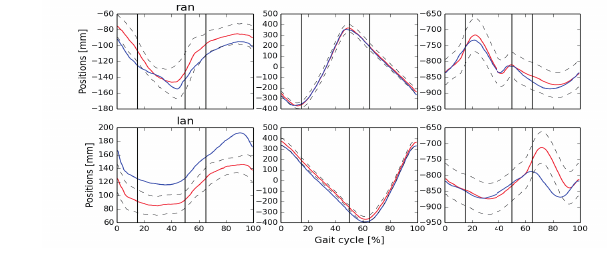
Figure 13: Comparison of ankle